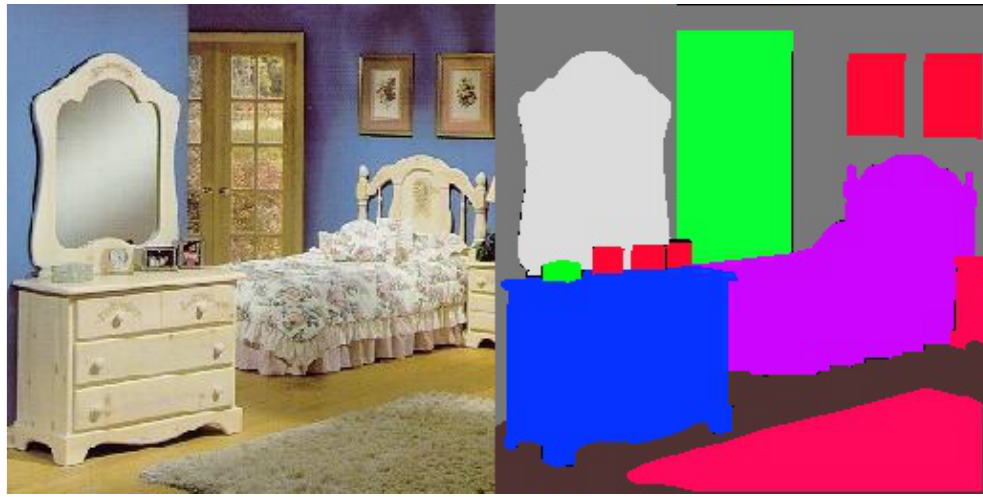
Figure 1. An image and its annotation from the ADE20K dataset. Table 1. Relevancy between different classes. The numbers in the table indicate the proportion of connected components labeled as one class that is adjacent to connected components labeled as another class. For example, floor is the closest class to wall. A total of 64.49% of the connected components labeled wall are adjacent to the connected components labeled floor. Lake is the farthest class from wall. There are no connected components labeled wall adjacent to a connected component labeled lake.